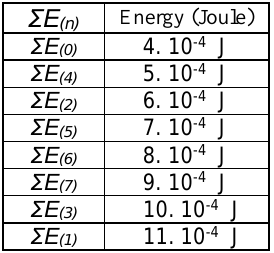
Table 2. Contribution individually of the energy ΣE